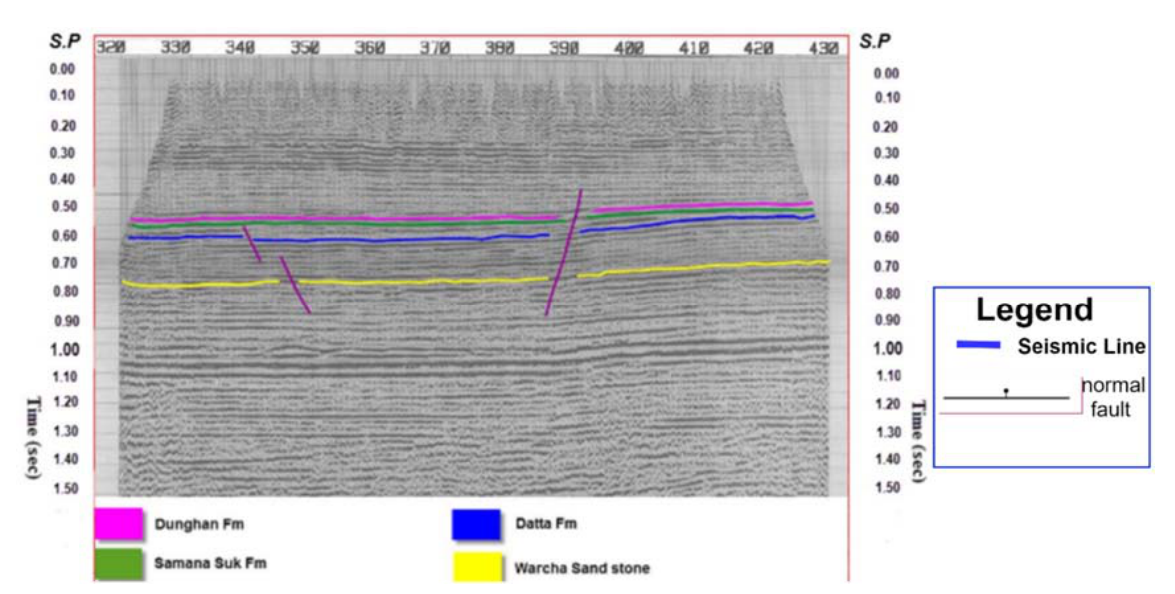
Figure 6. Marked seismic horizons of 875-KBR-230 line.